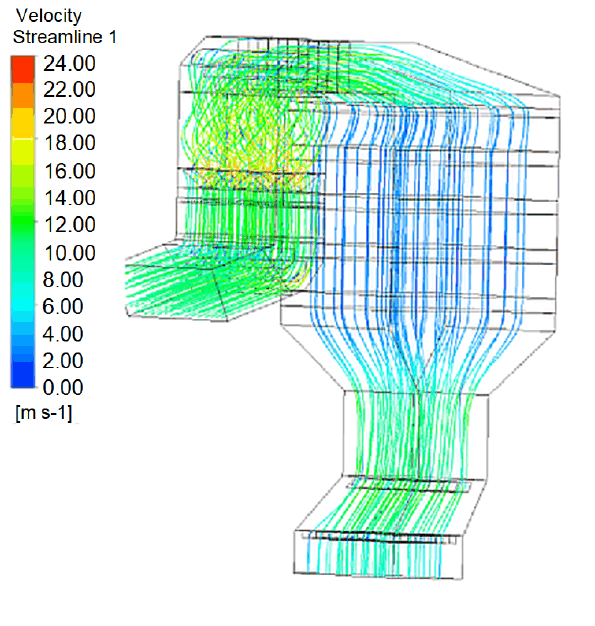
Figure 9. System streamline diagram with static mixer